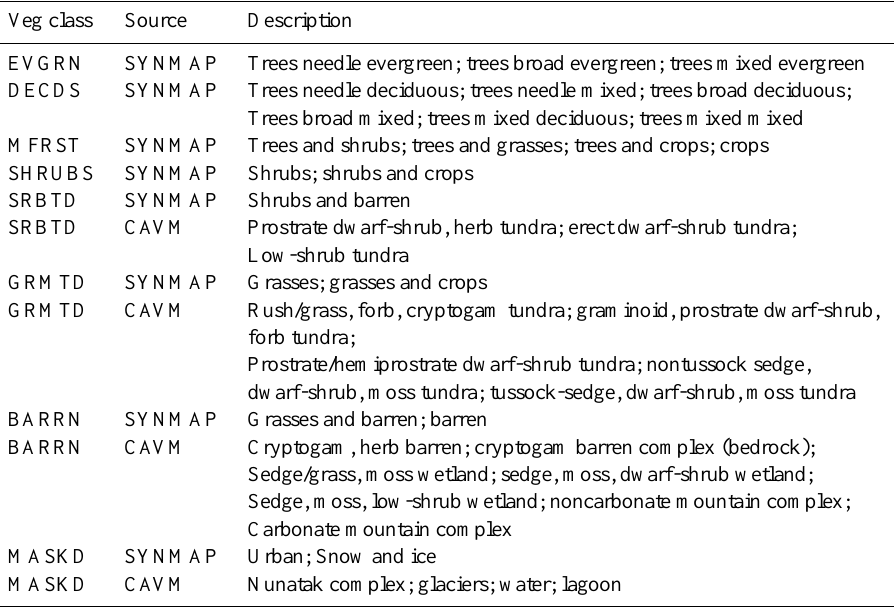
Table 1. Aggregation of forest SYNMAP and CAVM vegetation classes into a categorization that divides the pan-Arctic into seven broad vegetation classes: evergreen forest (EVGRN), deciduous forest (DECDS), mixed forest containing shrubs or grasses (MFRST), shrub- dominated region (SHRUB), graminoid tundra (GRMTD), shrub tundra (SRBTD), barren vegetated region (BARRN). Regions of water or permanent snow and ice (MASKD) are excluded from the analysis.